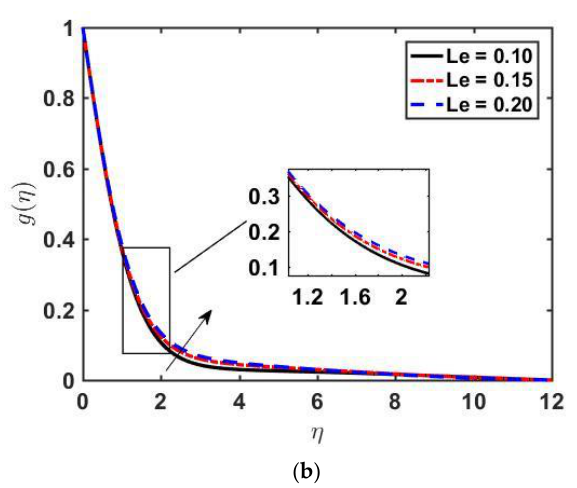
Figure 5. Profiles of θ ( η ) and g ( η ) versus η for various values of Le by fixing λ = 0.3, M = 0.5, Pr = 0.5, Nbt = 2.0, Nc = 0.5, and Sc = 2.0.